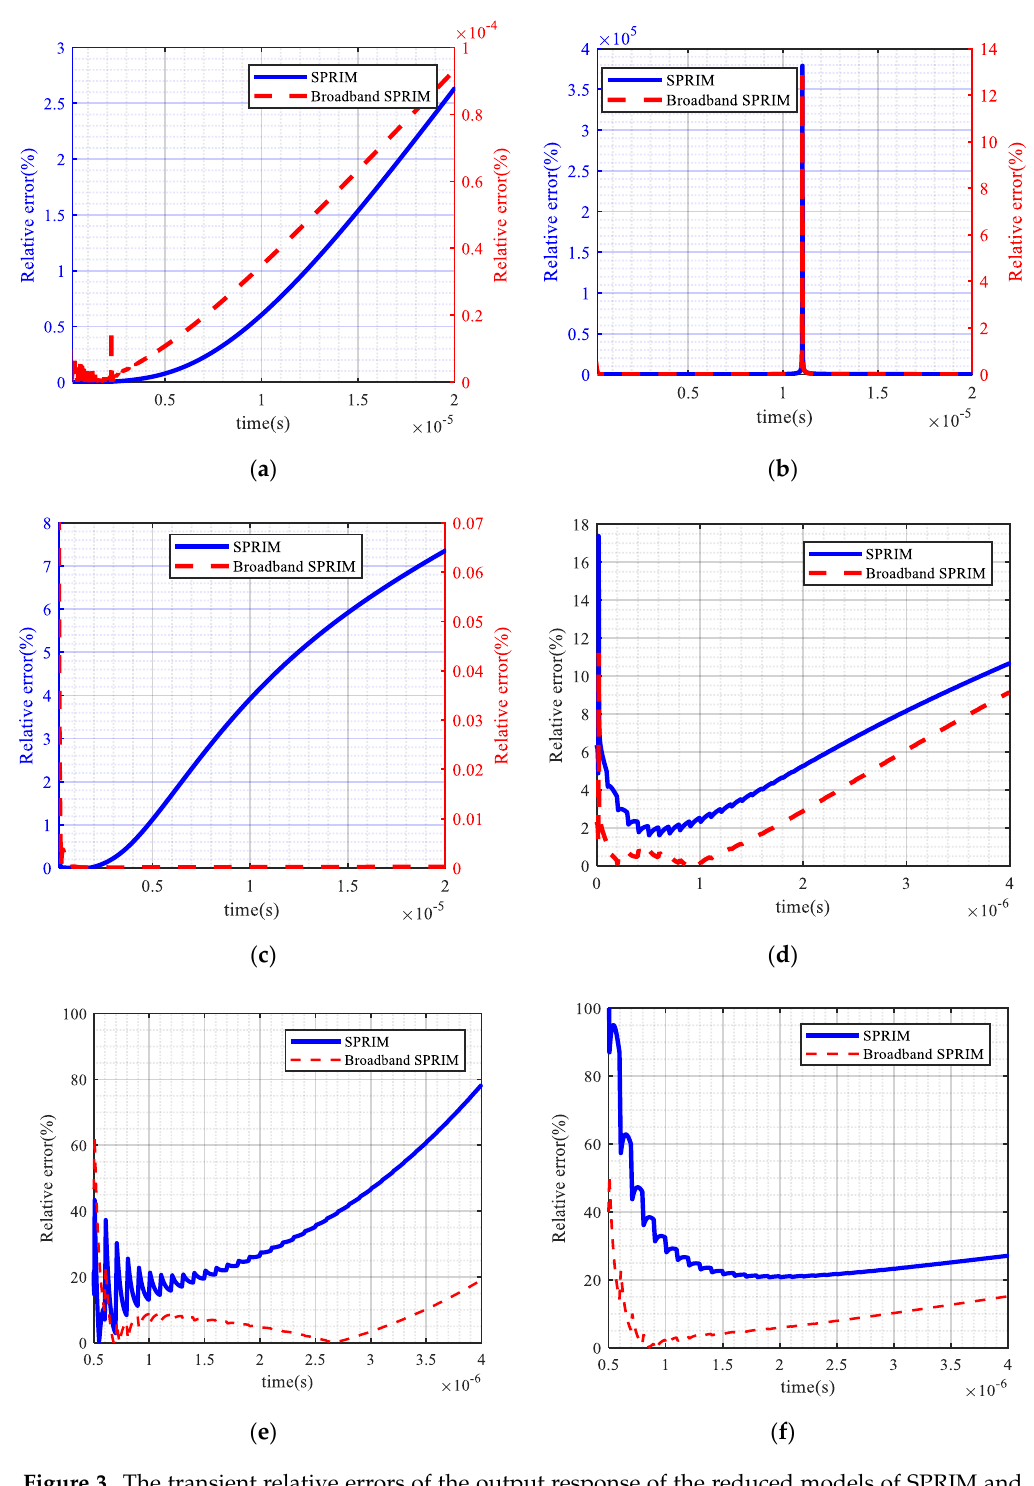
Figure 3. The transient relative errors of the output response of the reduced models of SPRIM and the proposed broadband SPRIM to those of the full-order circuit model under a tested turn-off signal excitation (( a – c ), reduced size = 18, s 0 = 1 × 10 5 for SPRIM), and a square wave excitation of frequency f = 10 7 Hz, duty cycle = 0.1. (( d – f ), reduced size = 12, s 0 = 1 × 10 7 for SPRIM). ( a ) y1. ( b ) y2. ( c ) y3. ( d ) y1. ( e ) y2. ( f )